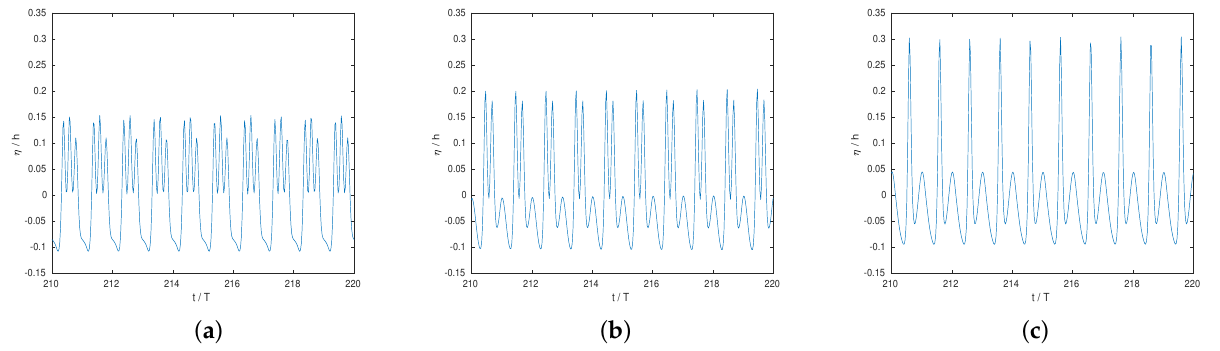
Figure 8. Dimensionless free surface elevations time histories of pure roll cases under different excitation frequencies: ( a ) ω / ω 1 = 0.96; ( b ) ω / ω 1 = 0.98; ( c ) ω / ω 1 = 1.02.